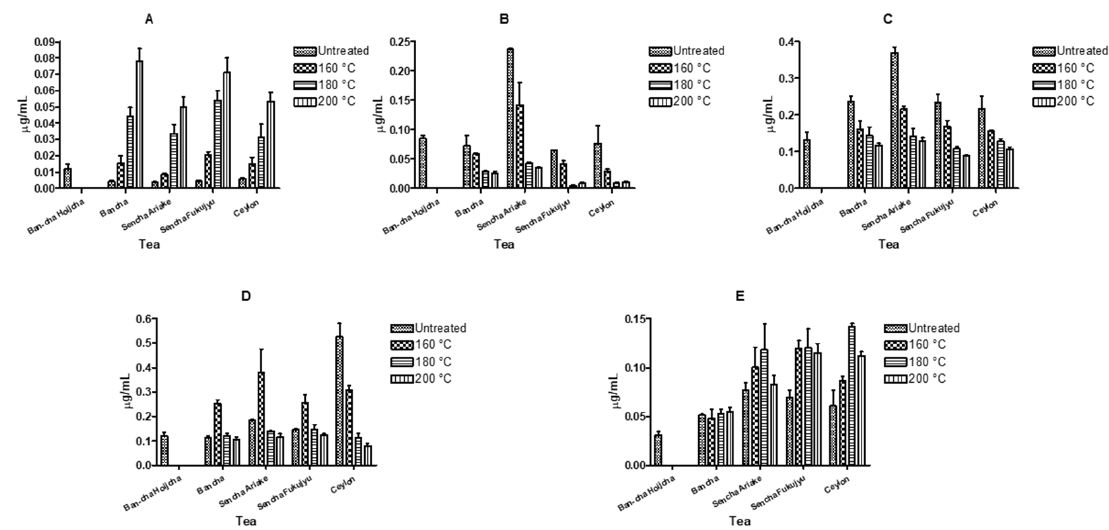
Figure 2. Effects of roasting temperature on the content of the odorants 2,4-heptadienal ( A ), β -damascenone ( B ), β -ionone ( C ), linalool ( D ) and indole ( E ). The roasting treatment and preparation for tea infusions were repeated three times. Each data value is expressed as mean ± standard deviation (n = 3).